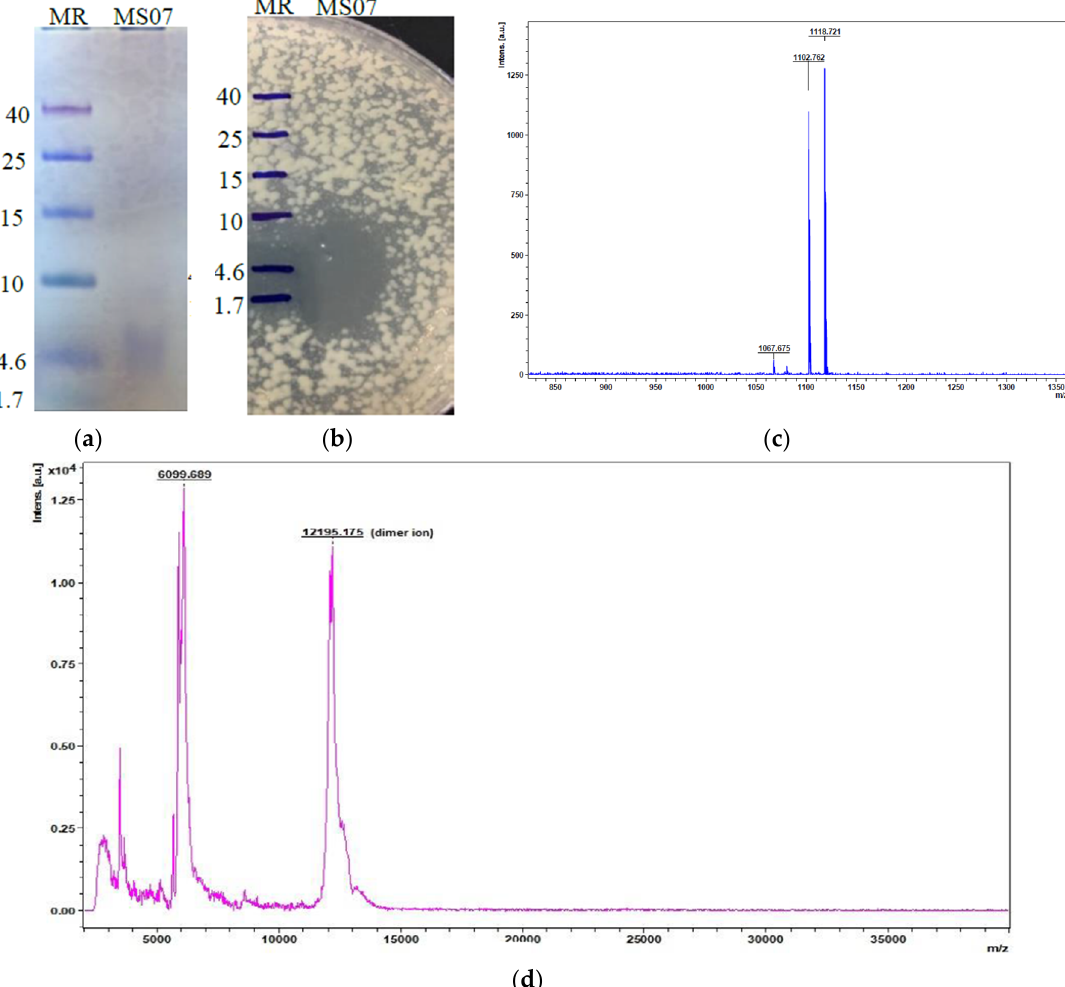
Figure 4. ( a ) Tricine-SDS-PAGE; Lane 1: standard protein indicator, Lane 2: purified MS07 after desalting. ( b ) In situ analysis (bioassay) against Mycobacterium smegmatis ATCC 9341; Lane 1: protein standard marker point, Lane 2: activity of purified MS07. ( c ) MALDI-TOF/MS showing m/z = 1067.675, 1102.762, and 1118.721 corresponding to lipopeptides. ( d ) Intact molecular weight determination by MALDI-TOF; purified MS07: 6099.689 Da, dimer ion: 12,195.175 Da.